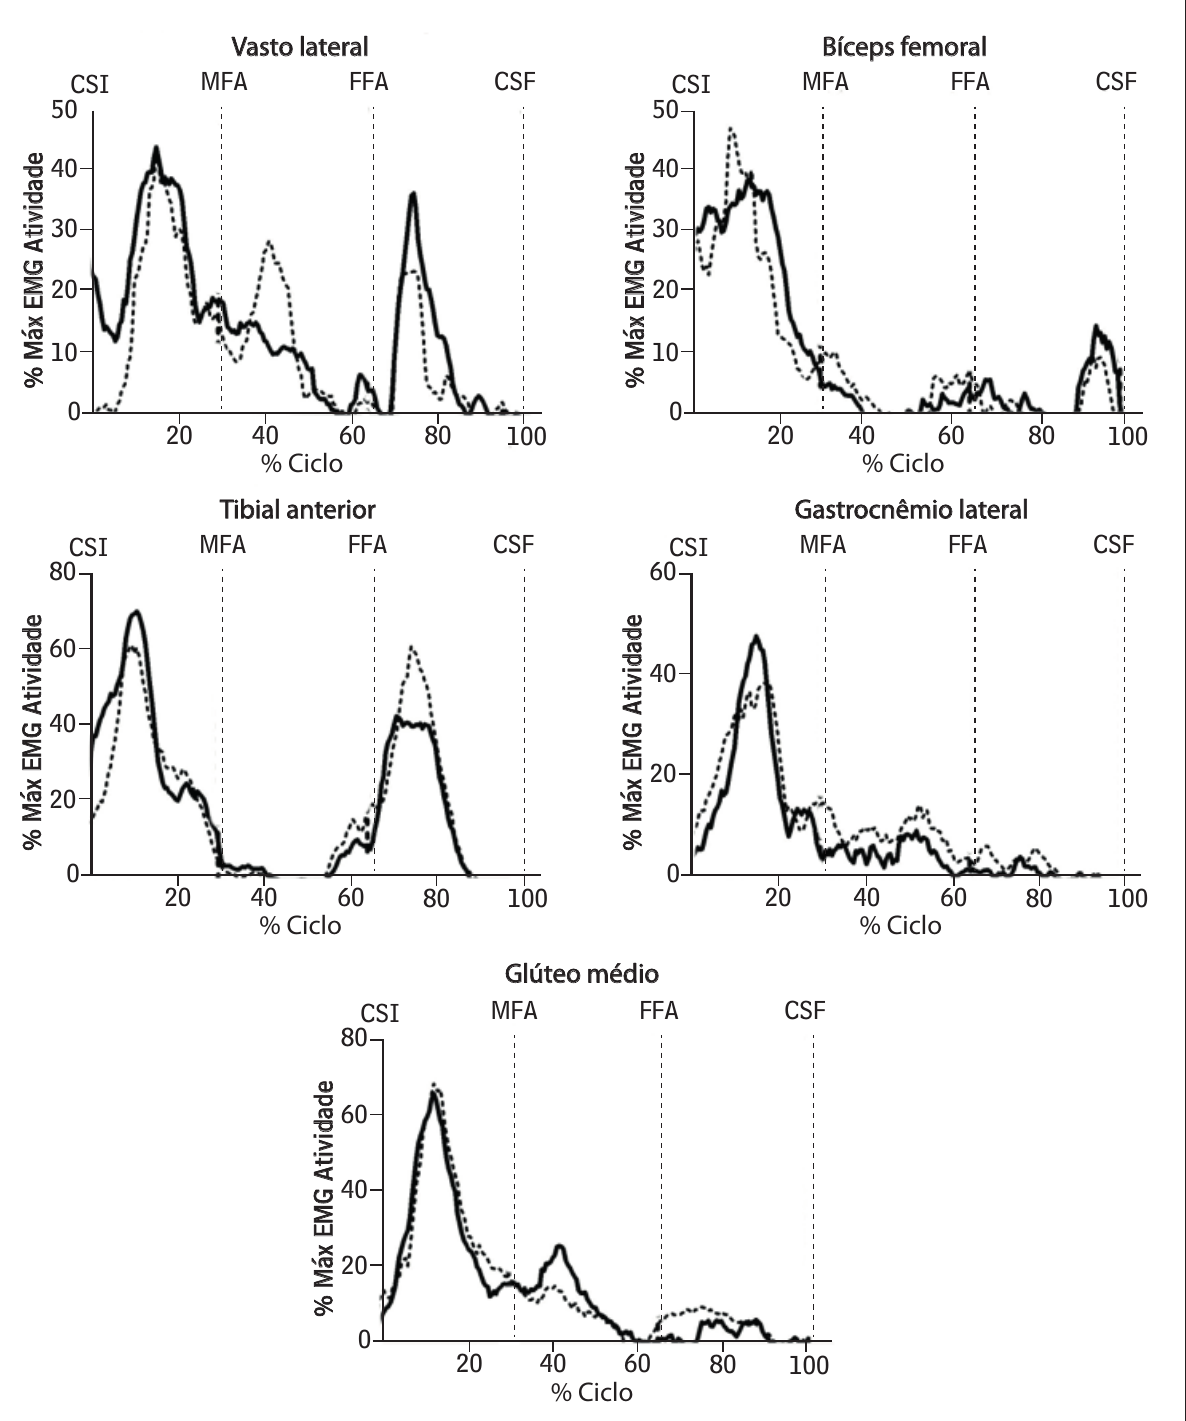
Figura 2 - RMS da EMG durante a descida Nota: PRÉ: linha pontilhada; PÓS: linha cheia; CSI: contato com o solo inicial; MFA: meio da fase de apoio; FFA: fi nal da fase de apoio; CSF: contato com o solo fi